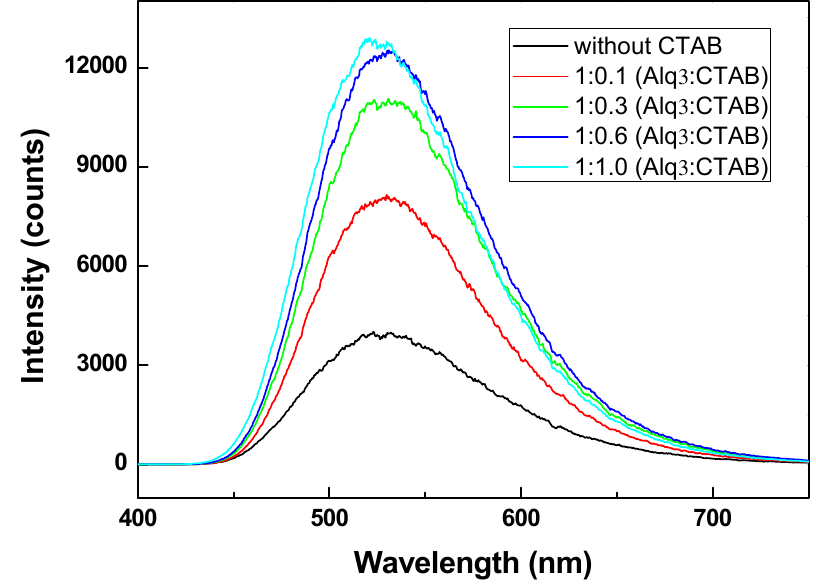
Figure 4. PL (photoluminescence) spectra of Alq 3 MCs depending on the molar ratio of Alq 3 to CTAB.